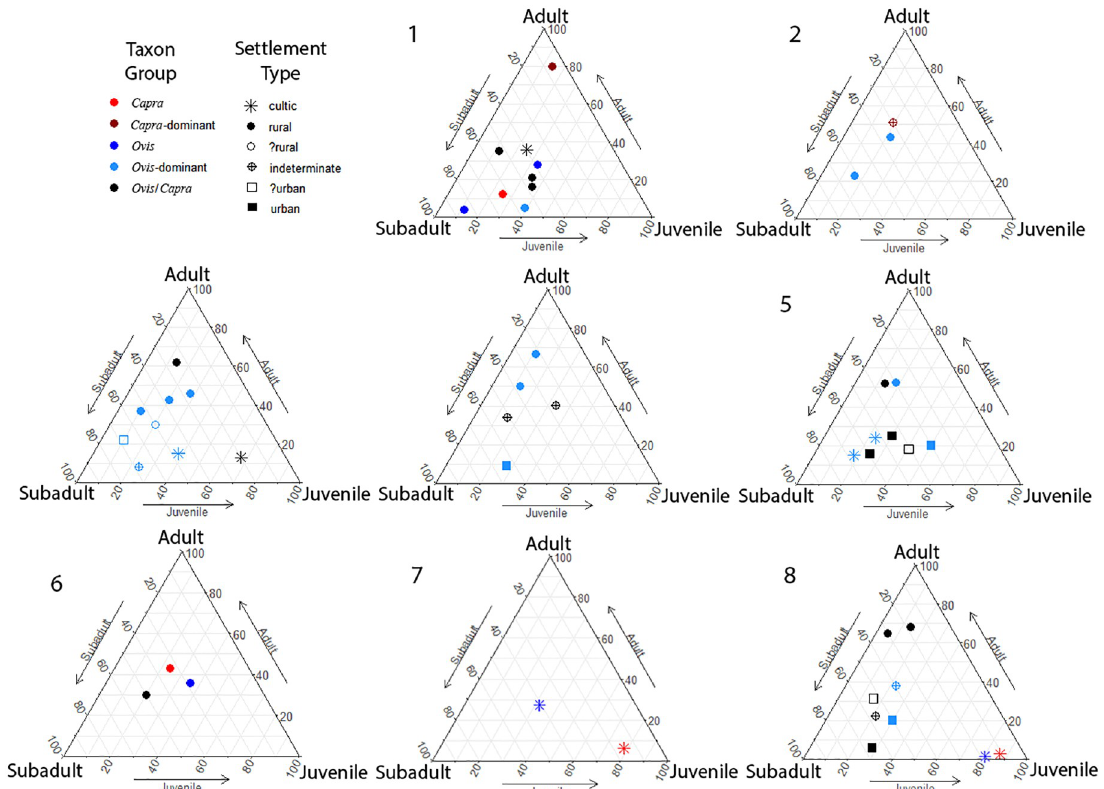
Fig 5. Ternary diagams of dental age profiles for sheep and goats from sites in this